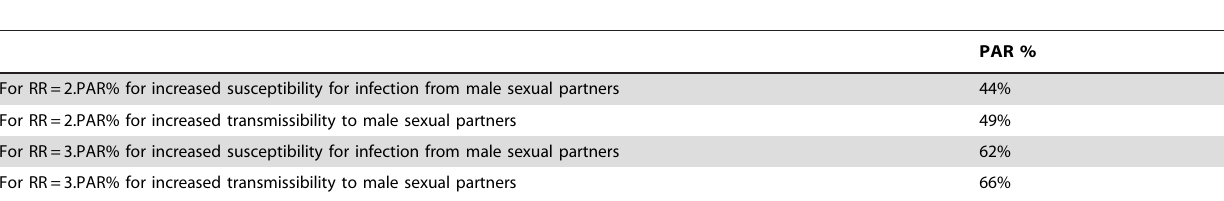
Table 4. Estimated Population Attributable Risk Percentages of HIV infection for HSV-2 as a Cause of HIV Transmission among Female Never-Injecting Drug Users in New York City,